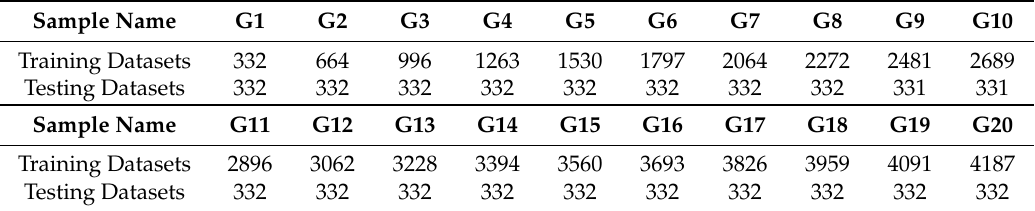
Table 1. Numbers of training and testing samples in each